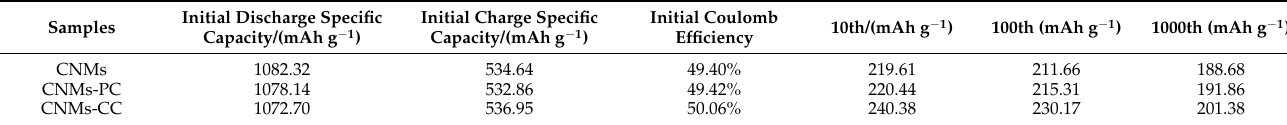
Table 2. The parameters of charge/discharge cycle data of samples.